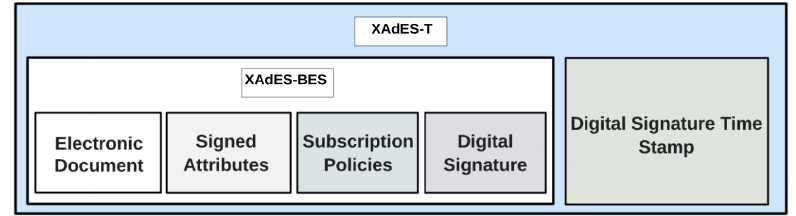
Figure 2. Digital signature with time reference